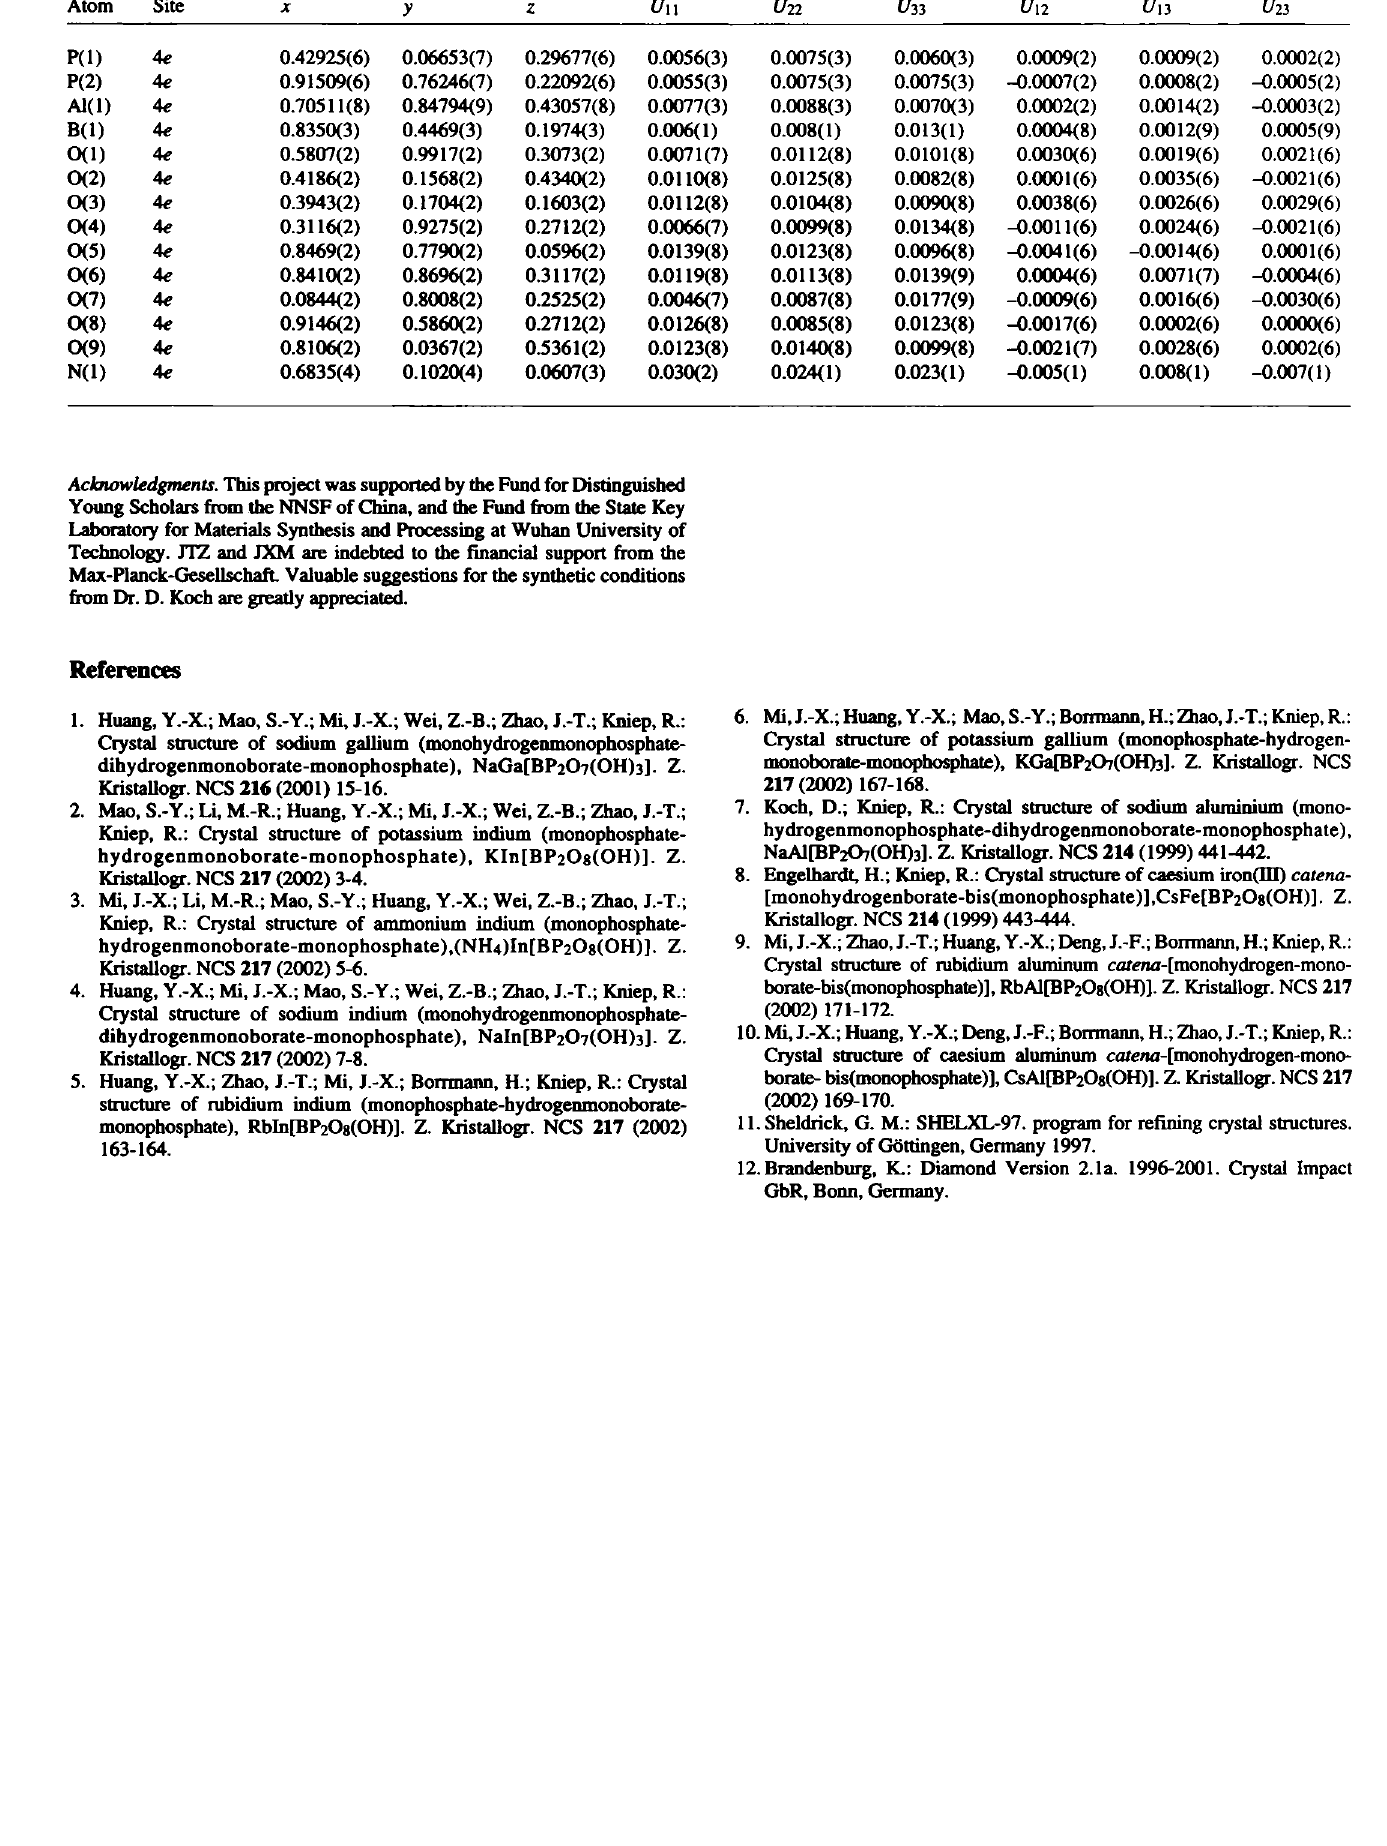
Table 3. Atomic coordinates and displacement parameters (in Â 2